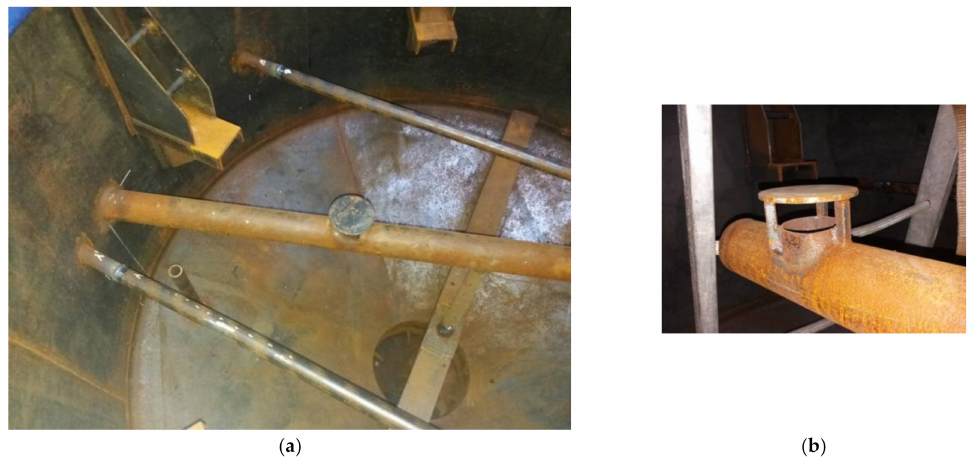
Figure 4. System for mixing the substrate in the reactor from the bottom-view: ( a ) components for suction; ( b ) fragment of the suction nozzle (photo by Grzegorz